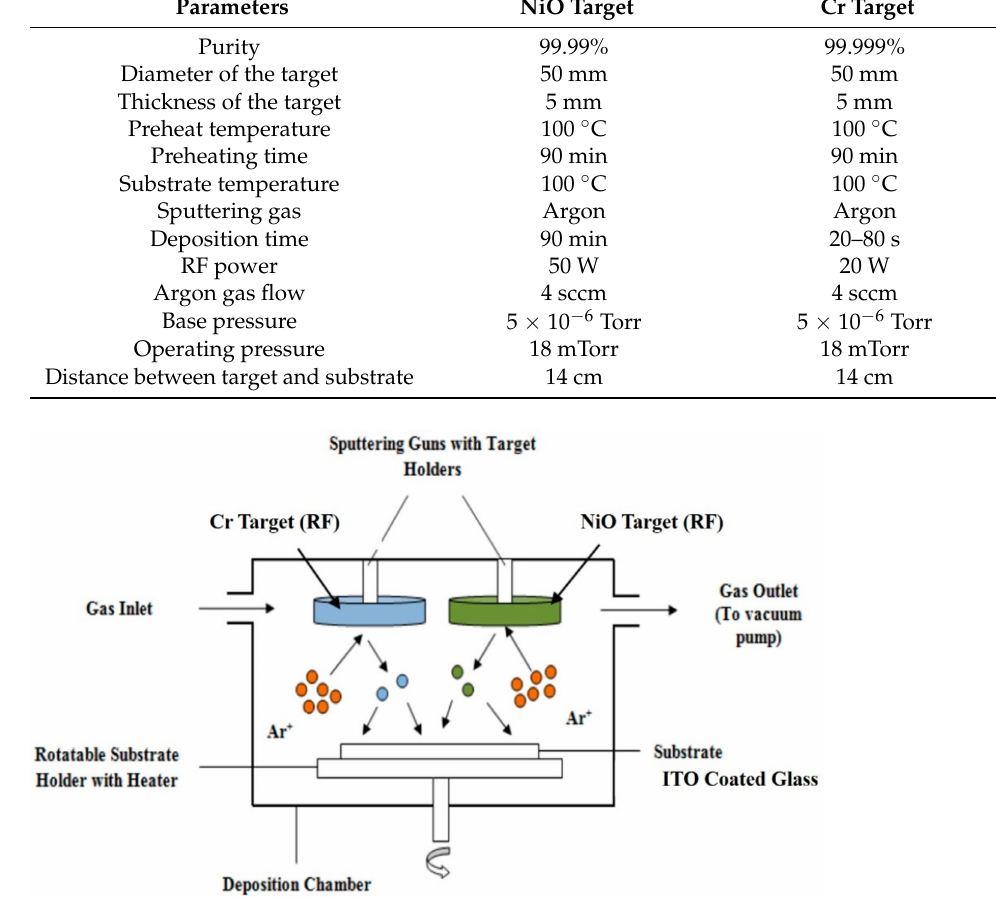
Figure 1. Schematic diagram of the sputtering